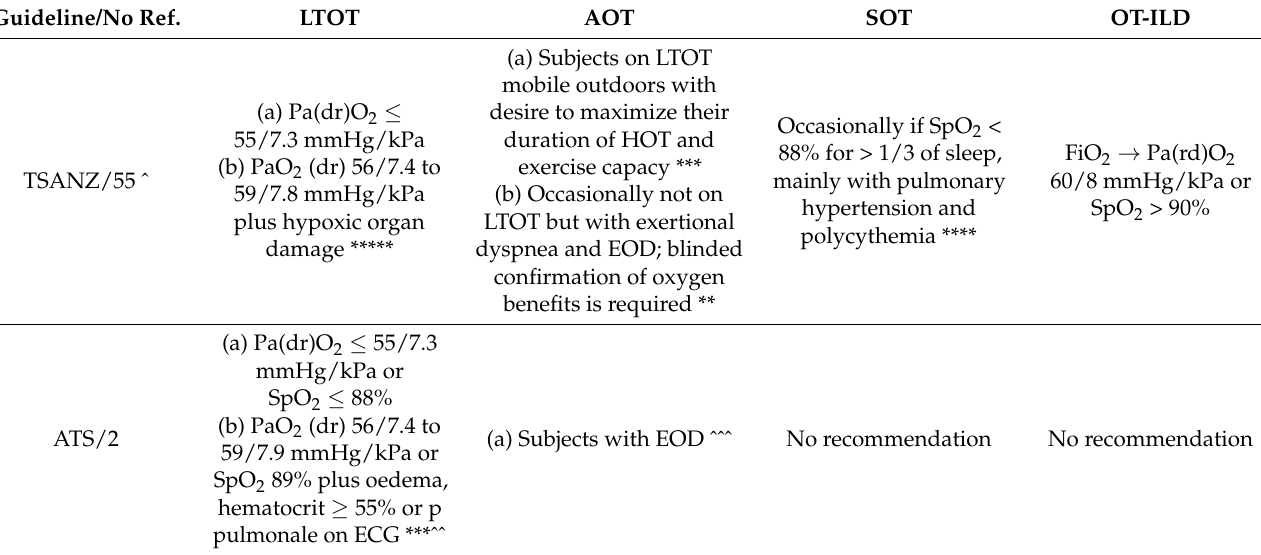
Table A4. Recommendations of guidelines on